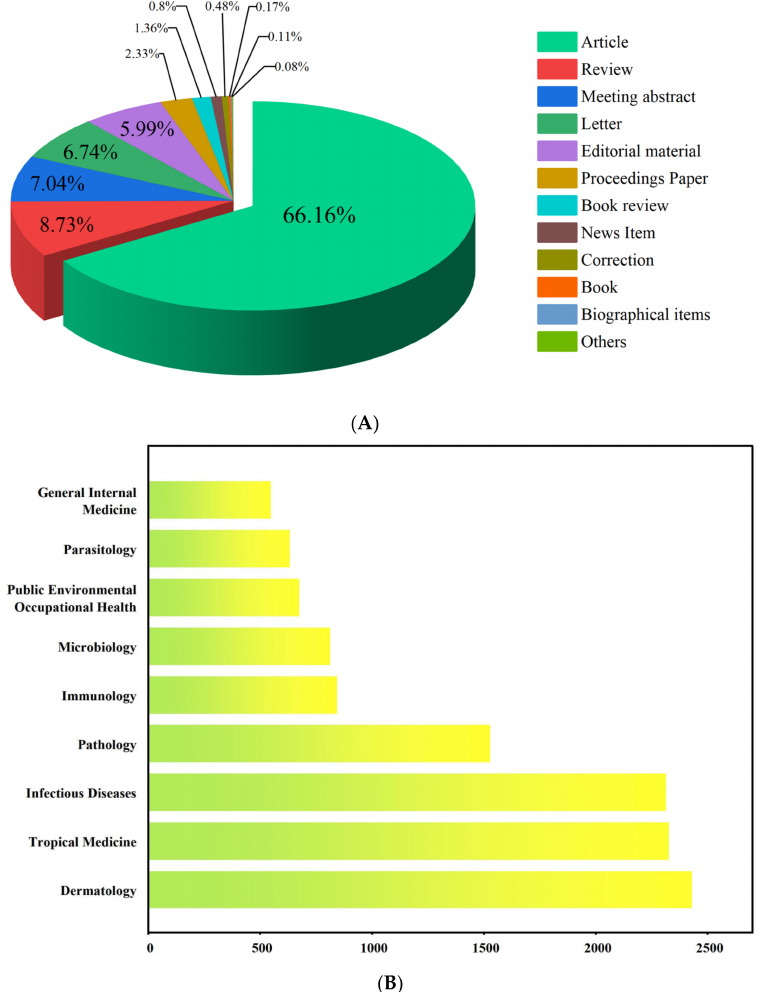
Figure 1. ( A ) Types of publications in the field of leprosy (2000–2021). ( B ) The top 10 subject categories in the field of leprosy